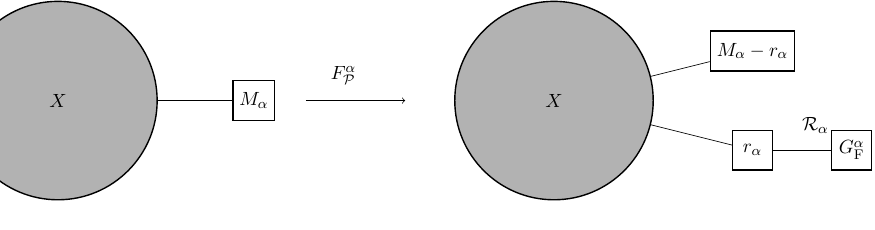
Figure 19 . Flavoring